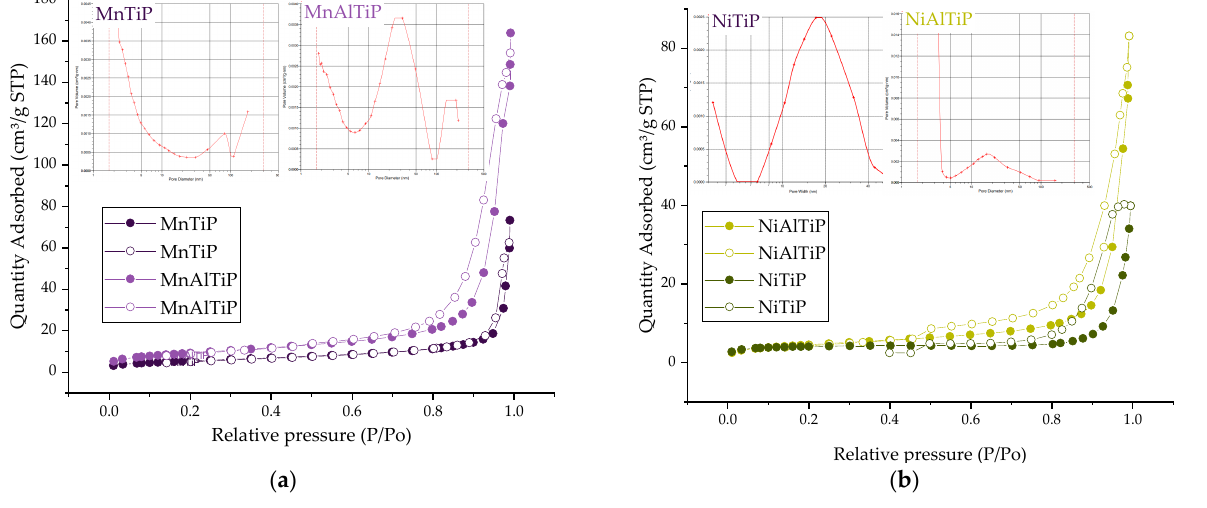
Figure 3. Nitrogen adsorption–desorption isotherms and pore size distributions of the compounds: ( a ) Mn 0.5 Ti 2 (PO 4 ) 3 (MnTiP), Mn 0.6 Al 0.2 Ti 1.8 (PO 4 ) 3 (MnAlTiP) and ( b ) Ni 0.5 Ti 2 (PO 4 ) 3 (NiTiP), Ni 0.6 Al 0.2 Ti 1.8 (PO 4 ) 3 (NiAlTiP).